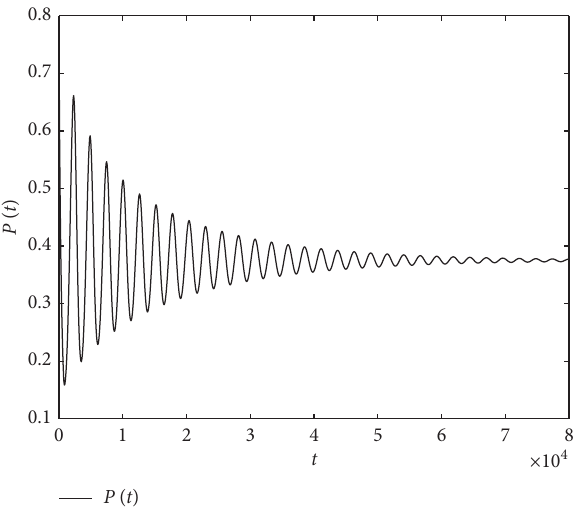
Figure 4: Time series solution of system (30) with ϕ � 0 . 90, � 728 . τ � 700 < τ 0